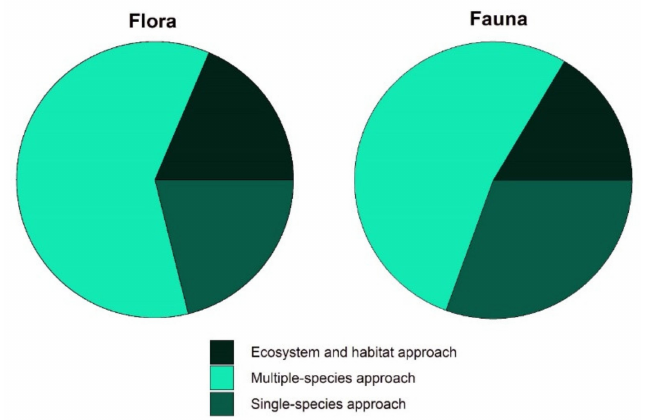
Figure 5. Proportion of the levels of prioritization approaches in conservation of flora and fauna resources in the reviewed